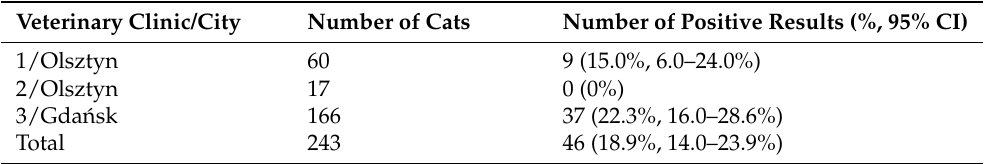
Table 1. Number of investigated feline samples and percentage of cats positive for SARS-CoV-2 antibodies by ELISA and iIFA in total and from individual clinics participating in this study. Veterinary Clinic/City